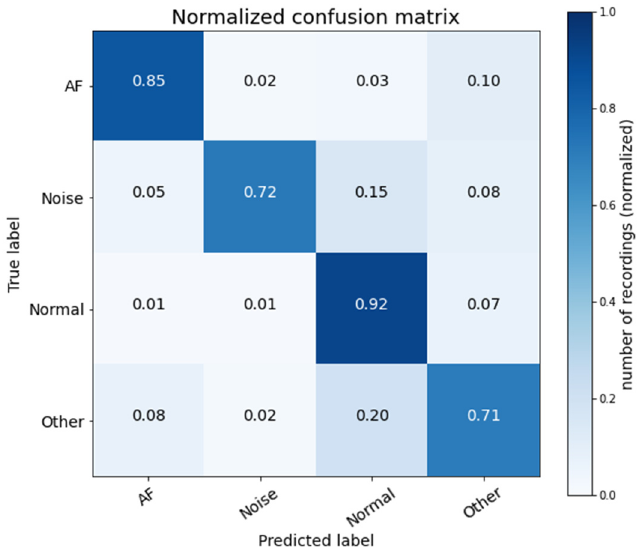
Figure 5. Normalized average confusion matrix of five folds.